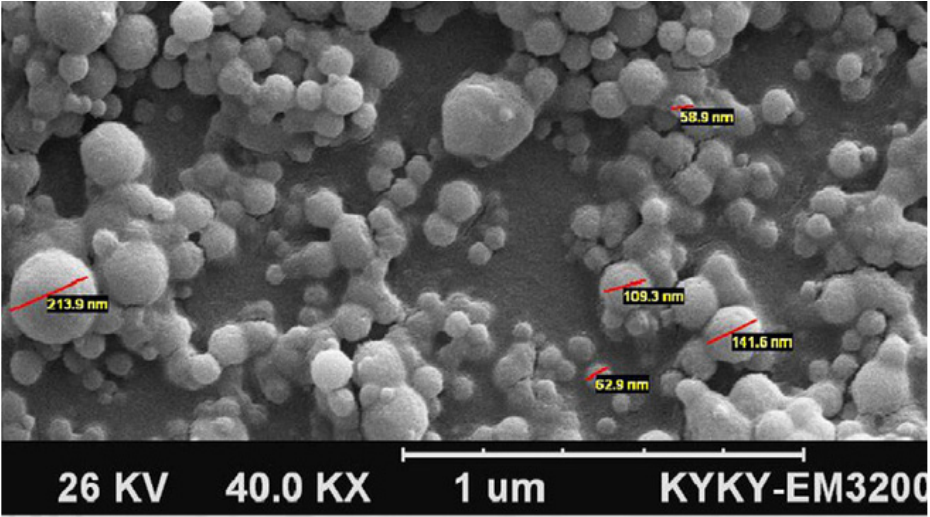
Figure 4. Scanning electron microscope (SEM) images of CuSQ-loaded solid lipid nanoparticles (SLNs). 2.5.2. Particle Size, Polydispersity Index (PDI), and Zeta Potential Analysis